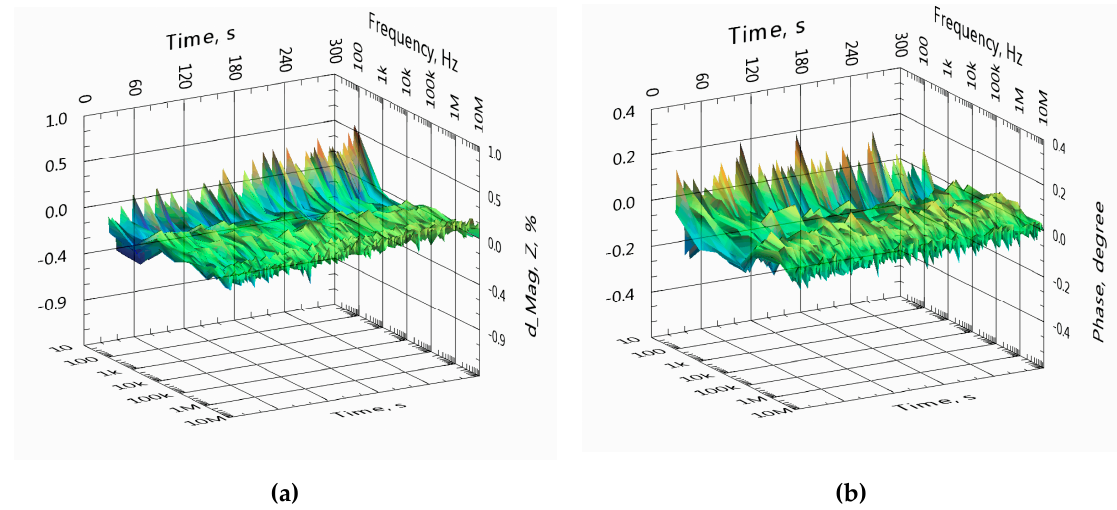
Figure 14. Overall variation of the impedance magnitude ( a ) and phase ( b ) of spectra during 5 min. The spectral data are collected from the same sensor and at the same timeframe as presented in Figure 15 for the single frequency of 10 kHz.